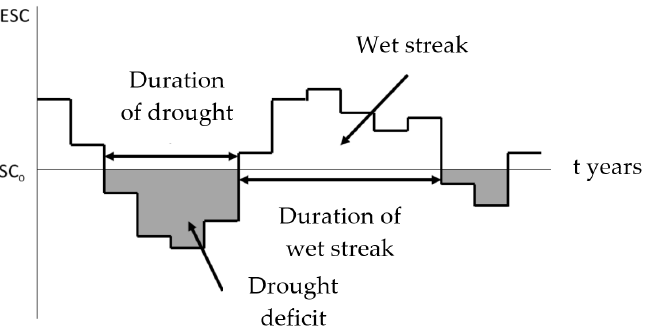
Figure 5. Concept and definition of droughts. Own elaboration based on [43] .